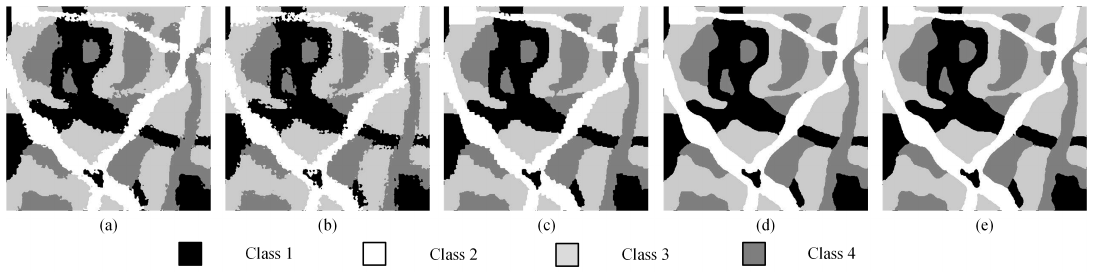
Figure 7. Comparison results of different SPM models for an artificial land image with a scale of 12.